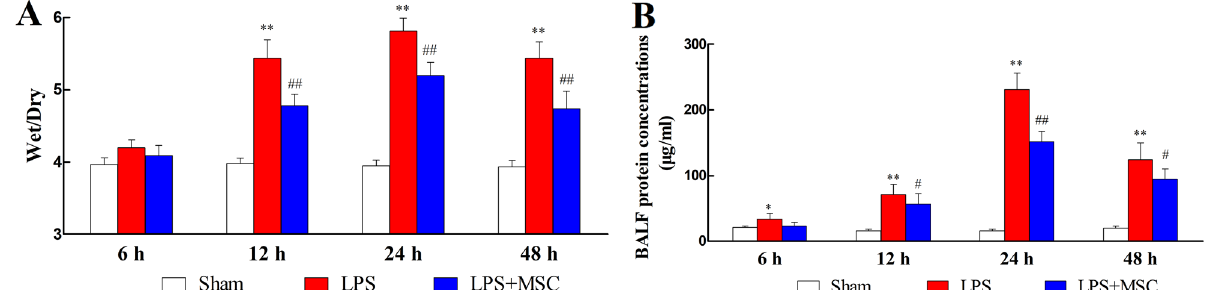
Figure 5. Effect of BM-MSCs on lung edema. ( A ) The wet/dry ratio of lung tissue. ( B ) Detection of total protein concentration. * P < 0.05 versus the Sham group; # P < 0.05 versus the LPS group; ** P < 0.01 versus the Sham group; ## P < 0.01 versus the LPS group. Values are expressed as the mean ±